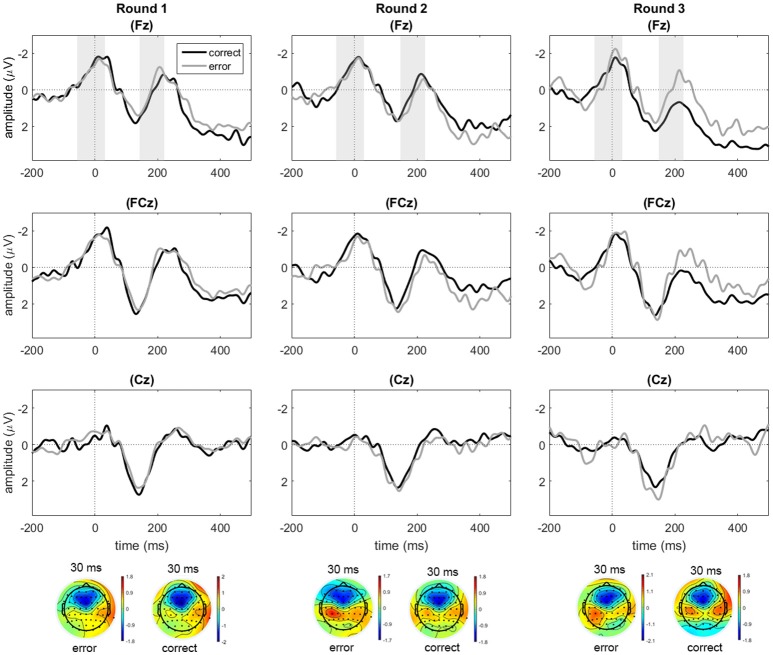
Response-locked data for correct and error responses in rounds 1, 2, and 3 at electrodes Fz, FCz, and Cz. Only for the purpose of depicting the data, an additional baseline correction was performed over the pre-response window starting from −200 ms. Shaded areas indicate the average time windows of the trough-to-peak amplitudes from the trough latency to the peak latency.